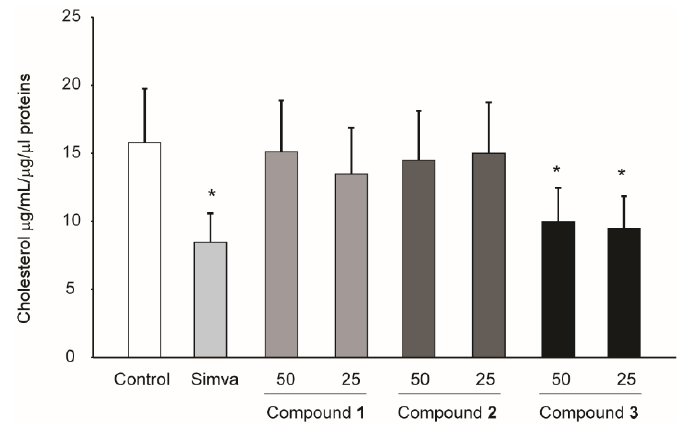
Figure 7. Effect of compounds 1 – 3 isolated from R. michauxii on intracellular cholesterol of the Huh7 cell line. Cells were incubated with MEM/10% FCS in the presence or absence of indicated concen- trations of compounds and 0.5 µM simvastatin (simva). After 72 h, total lipids were extracted, and cholesterol level determined by mass spectrometry analysis. These values were normalized by pro- tein levels. Each bar represents the mean ± SD of three independent experiments. * p < 0.05 vs. con- trol.